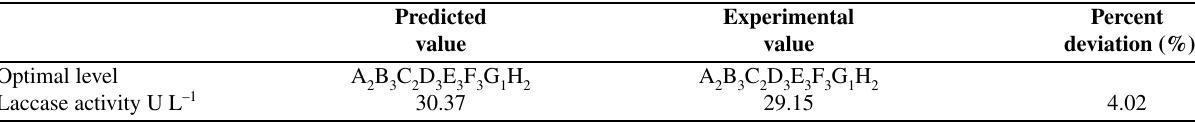
Table 6: Results of confirmation experiment Predicted Experimental Percent value value deviation (%) Optimal